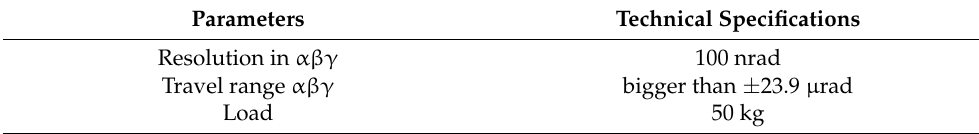
Table 4. Specification requirements for the customized piezo-driven